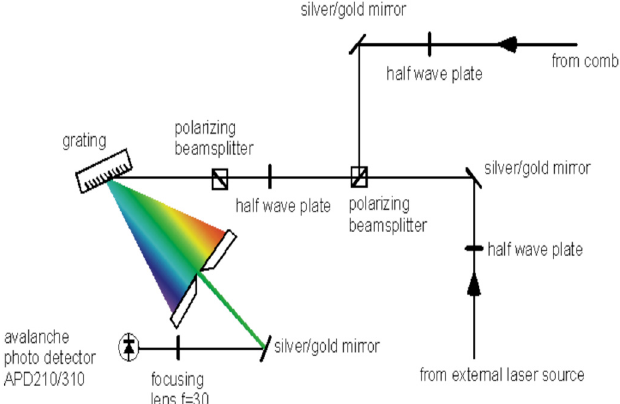
Fig. 4. Beat detection unit used for to measure the absolute frequency of different Zeeman-stabilized He – Ne lasers operating at 633 nm with a femtosecond comb